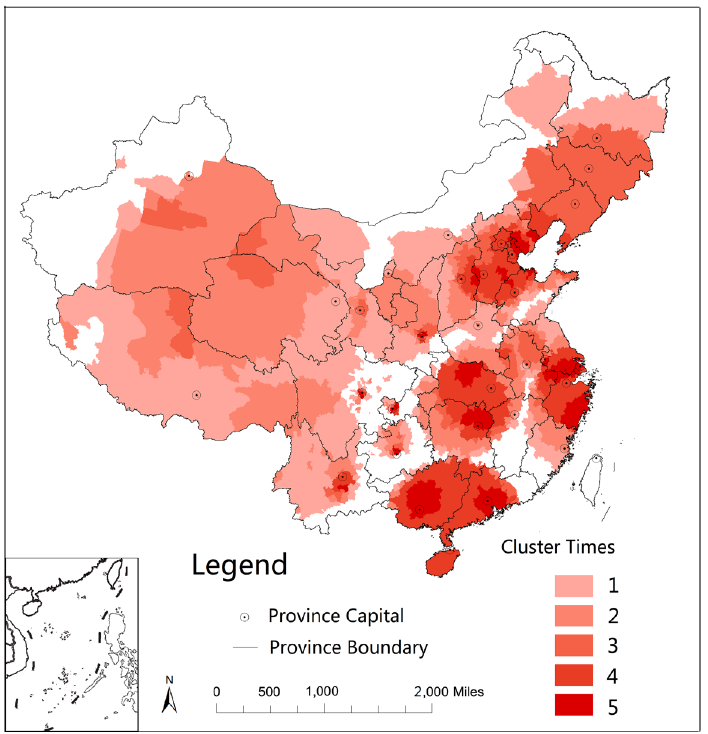
Fig 7. Detected times of spatiotemporal clusters of HFMD in mainland China, 2008 –